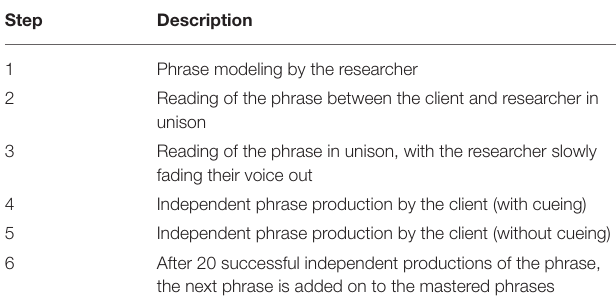
TABLE 1 | Script Training Procedures